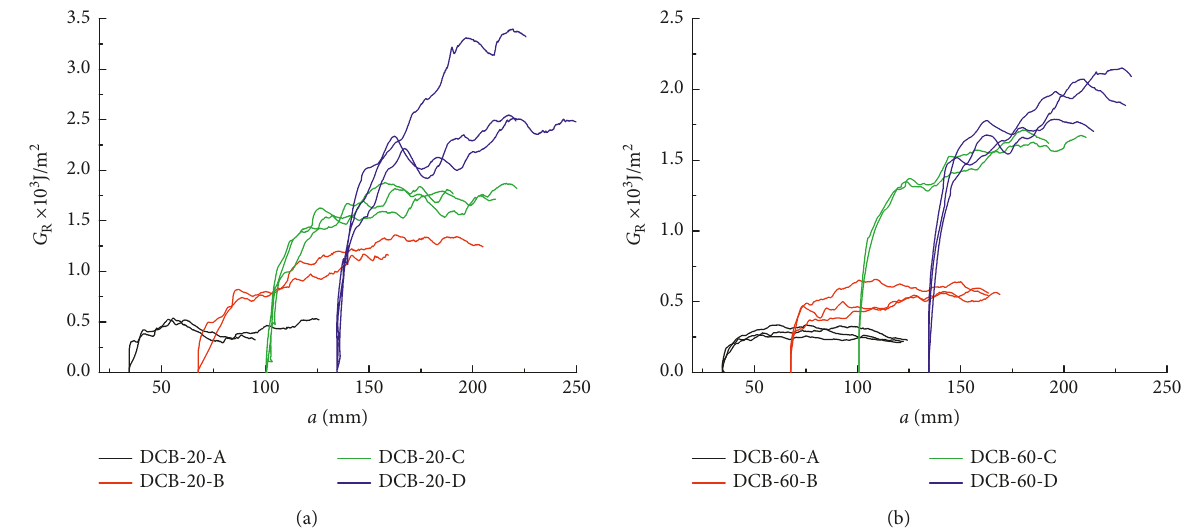
Figure 10: R-curves of DCB specimens with different initial crack lengths on the same width: (a) width B � 20mm; (b) width B �